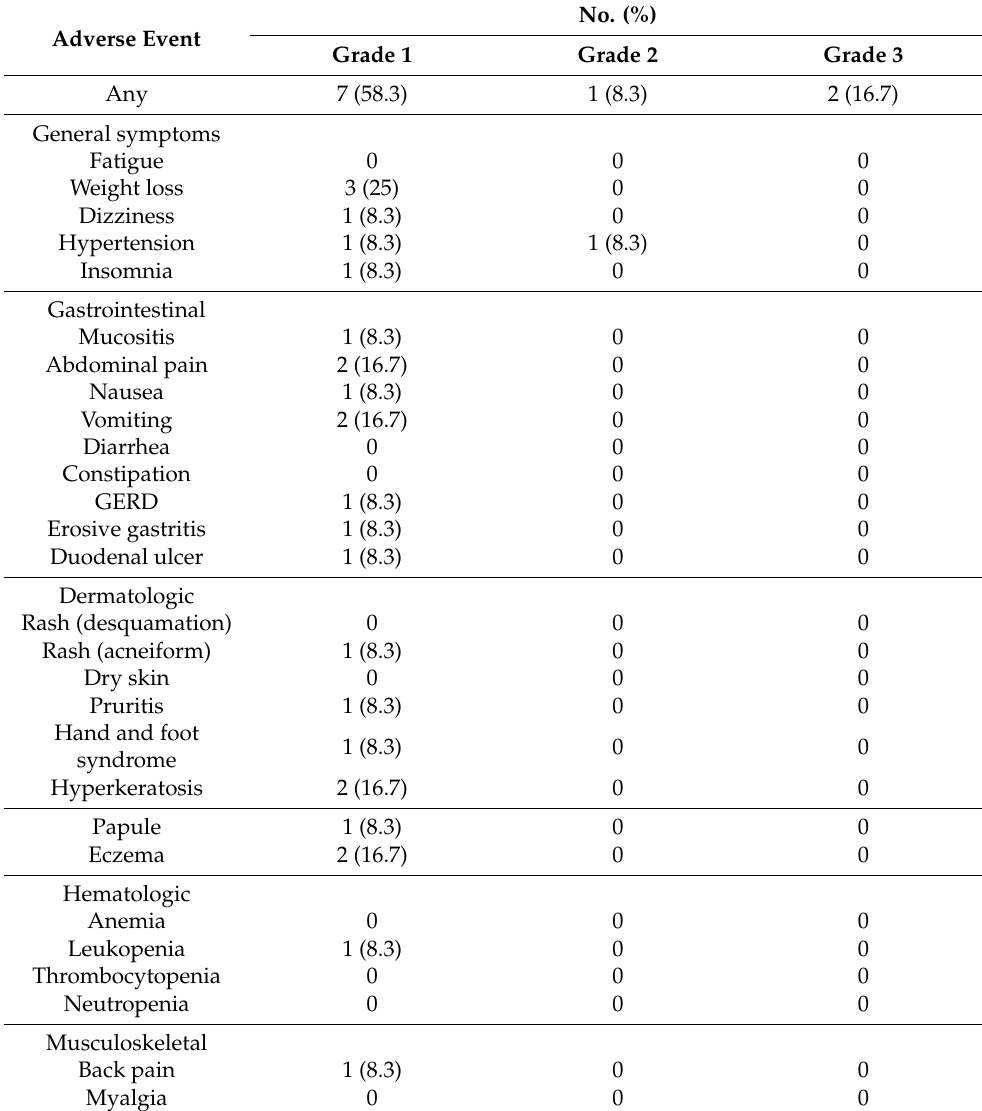
Table 2. Adverse events at least possibly related to study